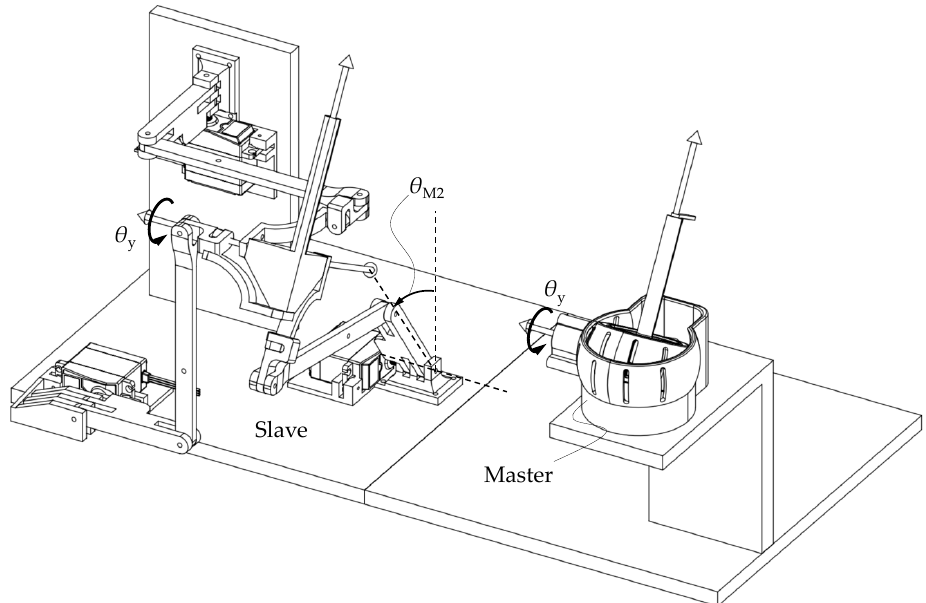
Figure 13. Mechanism configuration at t = 27.5 s.